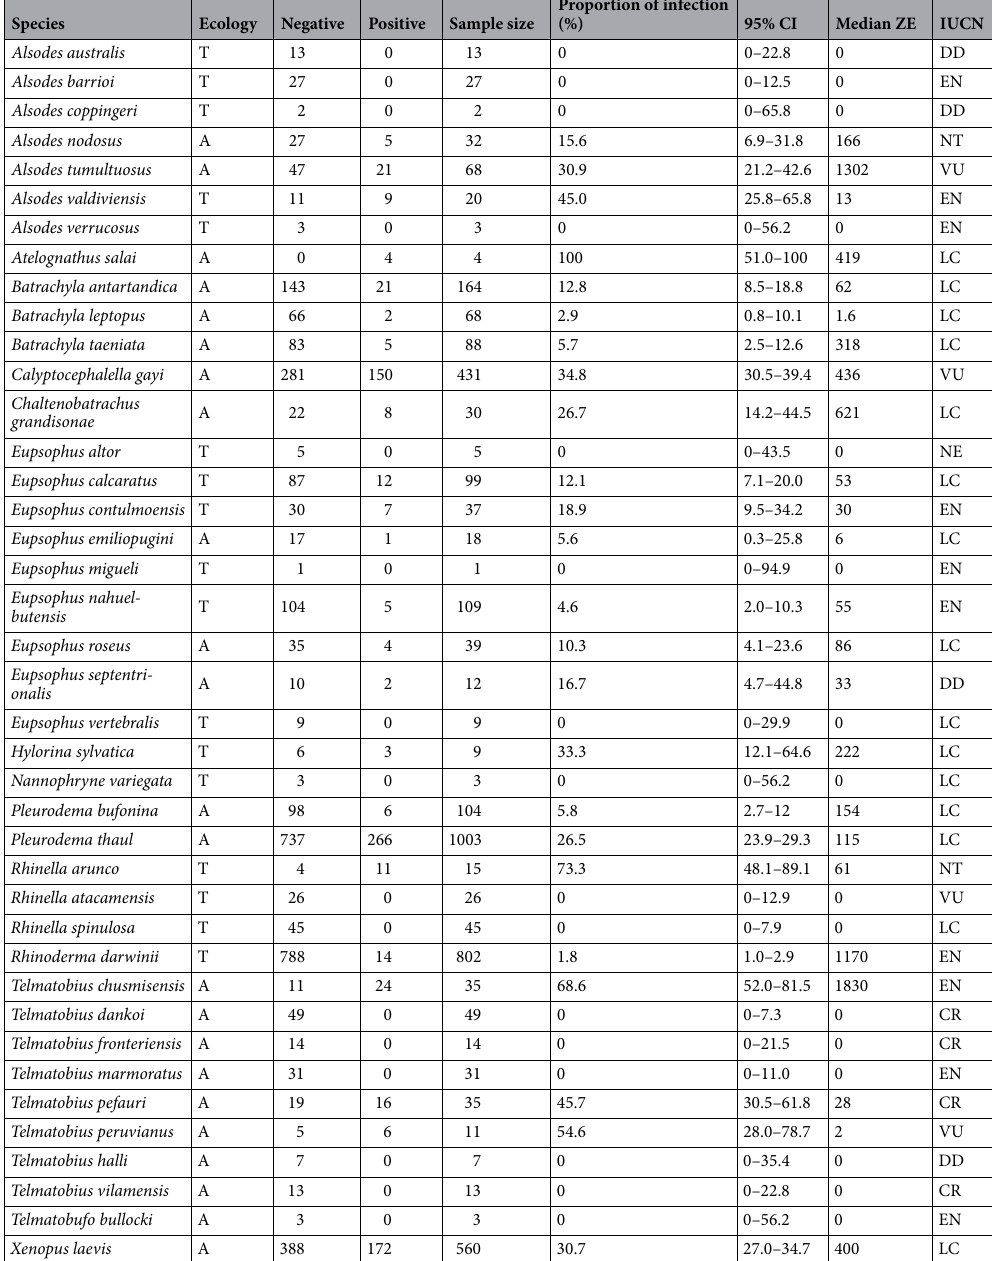
Table 1. Chilean anurans studied for Batrachochytrium dendrobatidis ( Bd ) infection from 2008 to 2018. Host ecology (aquatic = A, or terrestrial = T), positive, negative, sample size, proportion of Bd infection, and 95% binomial confidence intervals (CI). Bd infection loads are shown as median zoospore equivalents per swab (ZE). Conservation status for each species from the IUCN redlist is also